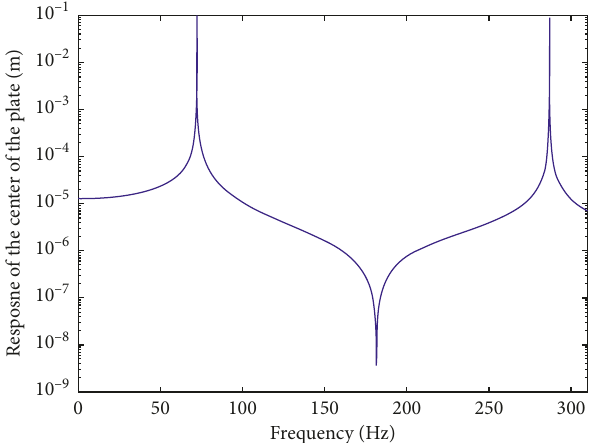
Figure 4: Response of the center of the multilayer plate calculated with the new plate